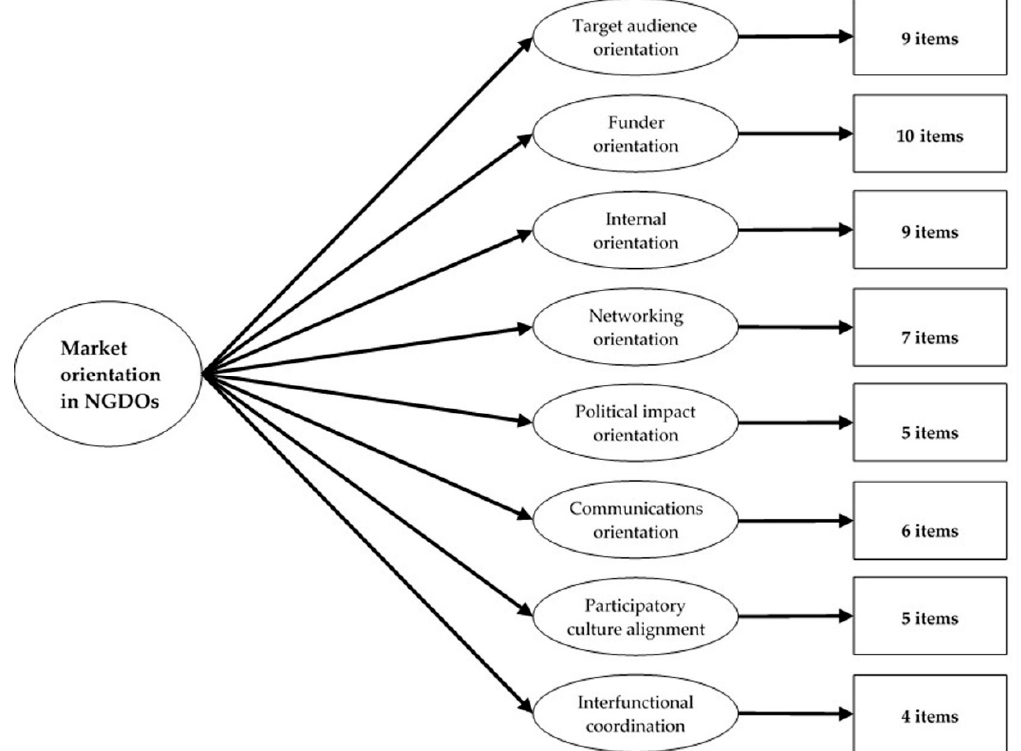
Figure 4. Final structure of the scale.